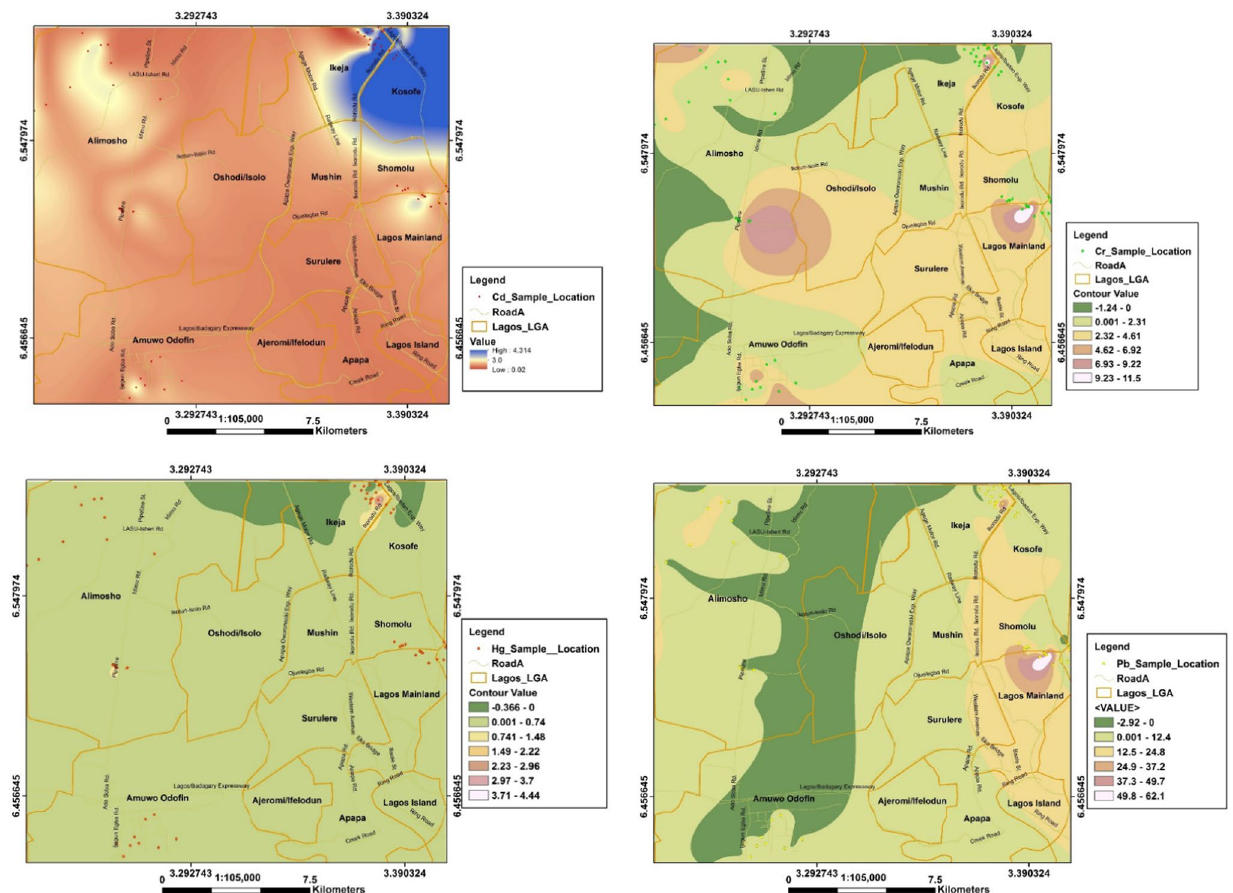
Fig. 5 Geochemical maps of some PTEs in the groundwater of study